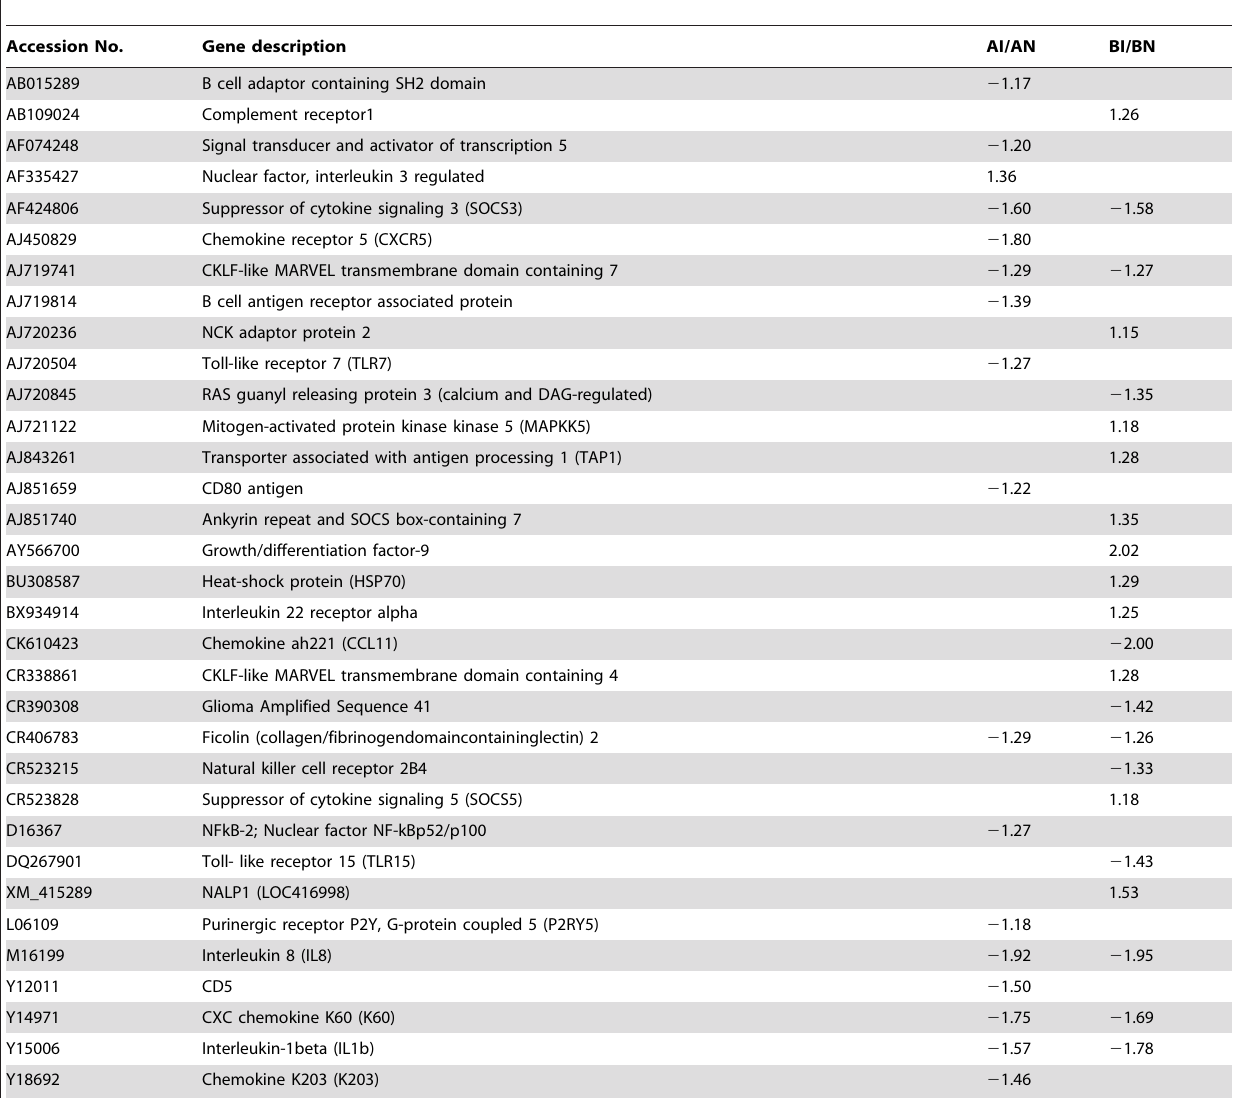
Table 2. Fold-change of significantly differentially expressed immune-related genes between inoculated and non-inoculated chickens within lines in microarray results ( P ,